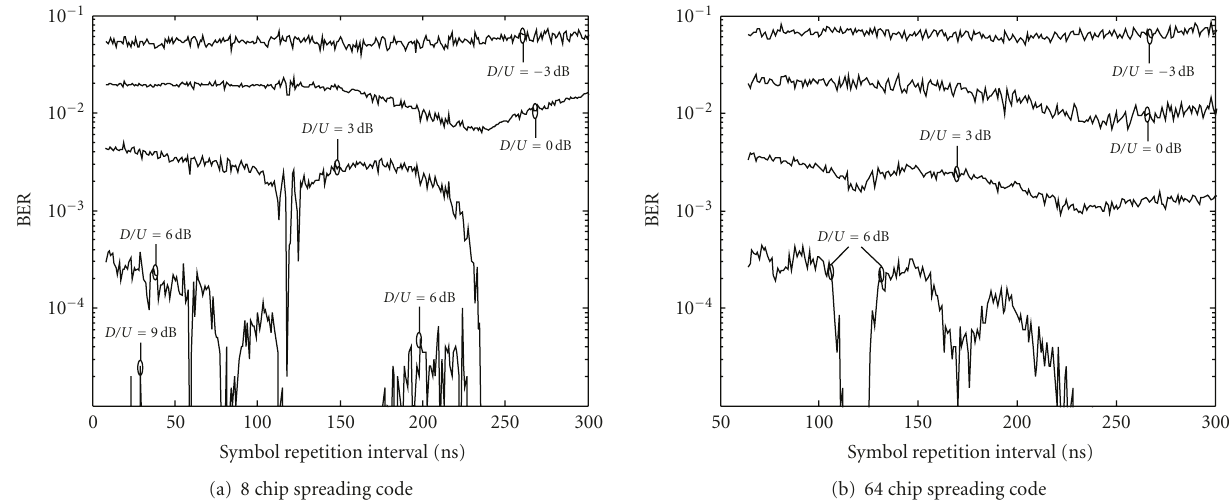
Figure 9: BER performance of OFDM signal interfered with by DS-UWB for changing symbol repetition intervals ( T c = 1 nanosecond).